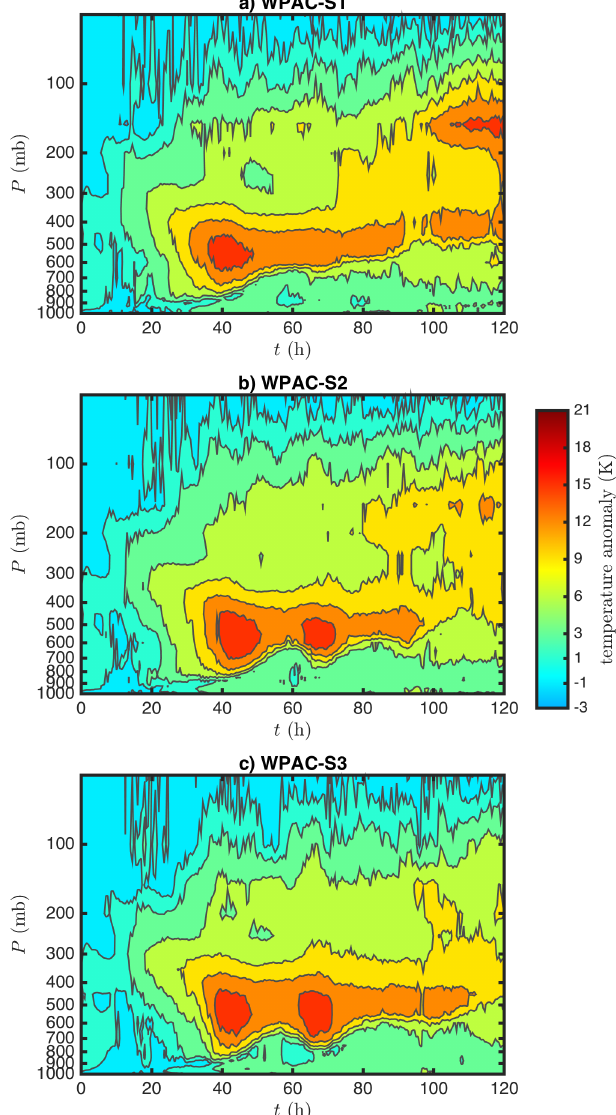
Figure 9. As in Figure 5 but for the WPAC subdomain